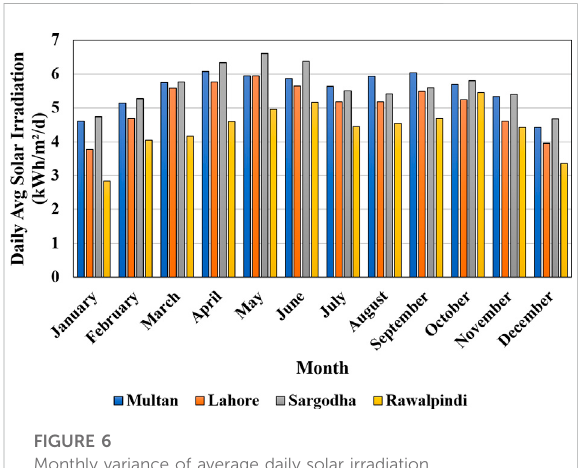
FIGURE 7 Monthly variance of ambient air